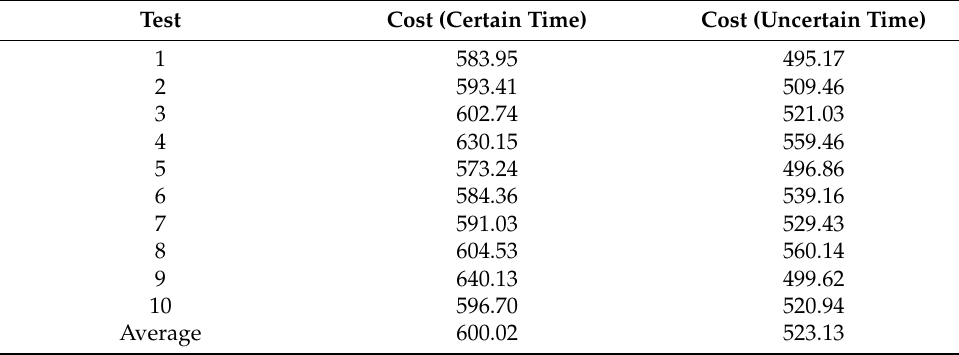
Table 8. Simulation results of C101.